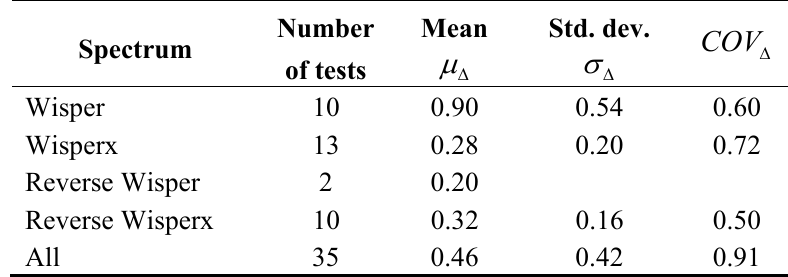
Table 3. Mean and standard deviations for estimated damage at failure for variable amplitude